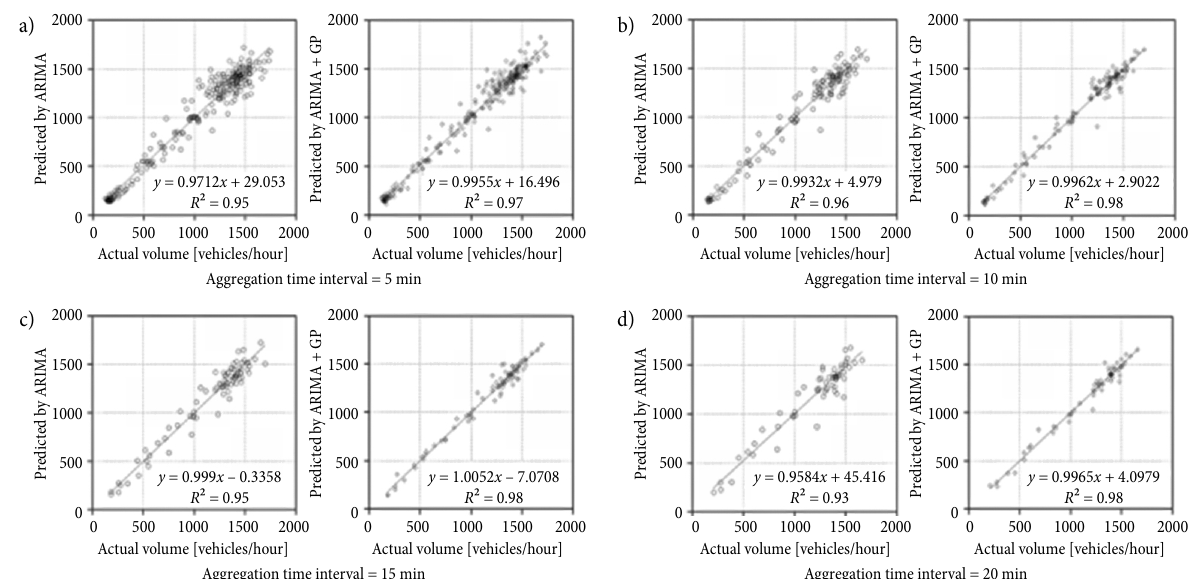
Fig. 9. Predicted versus actual volumes for different aggregation time intervals at Site